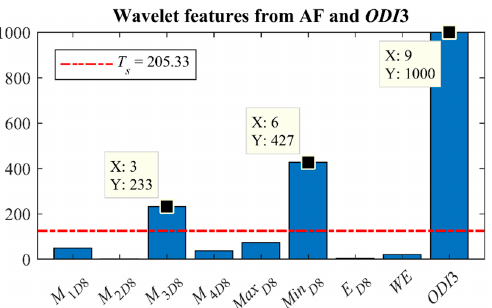
Figure 6. Results of feature selection using FCBF in 1000 bootstrap from the training group with wavelet features from AF and ODI 3.